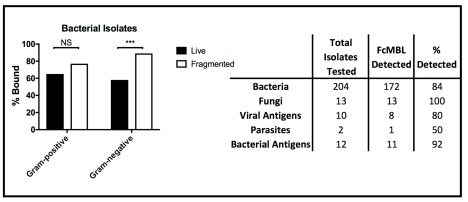
Summary of FcMBL pathogen capture.(Left) Percent of live and fragmented Gram-positive (
n = 78) and Gram-negative (
n = 117) bacterial isolates bound by FcMBL ELLecSA. (Right) Chart showing total number of isolates tested by FcMBL ELLecSA for bacteria, fungi, viral antigens, parasites, and bacterial antigens, total number FcMBL detected, and total percent detected overall. ***p-value < 0.0001; Pearson’s chi-squared test. NS, not significant.